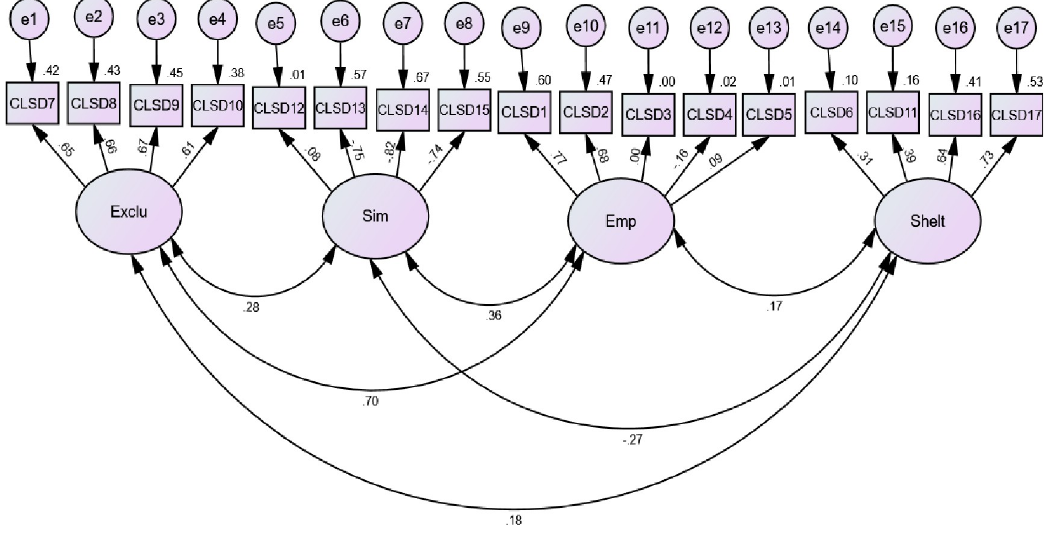
Fig 1. CFA of CLAS-ID